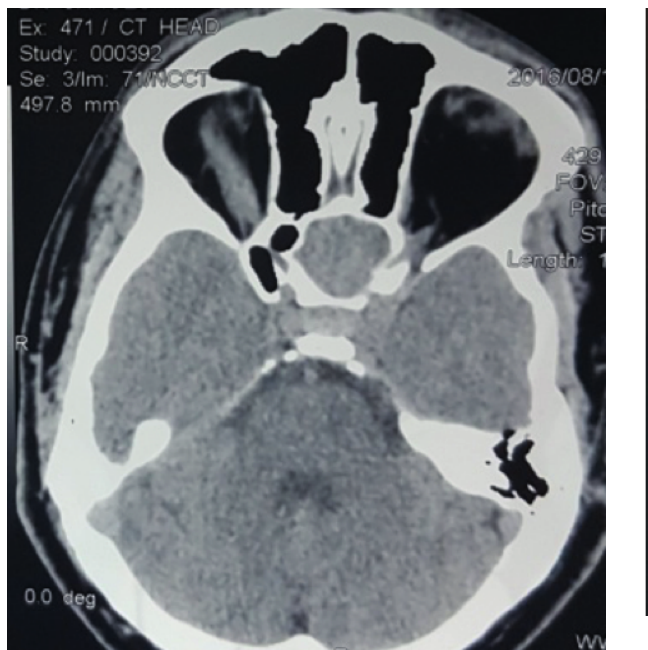
Figure 2. MRI showing soft tissue mass with moderate signal intensity in the region of sphenoid